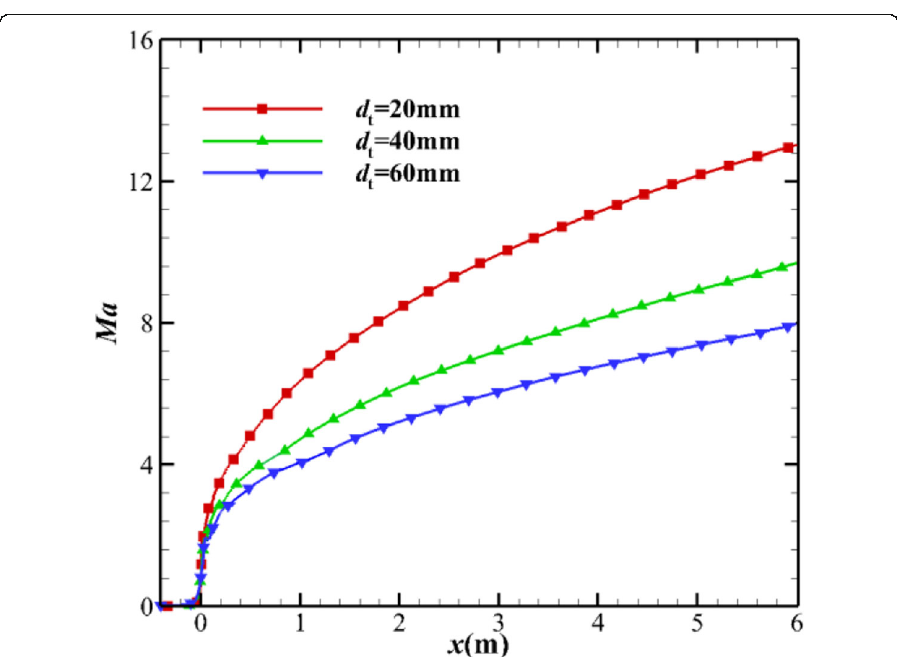
Fig. 13 Comparison of the exit Mach number distribution based on the FD-21 nozzle